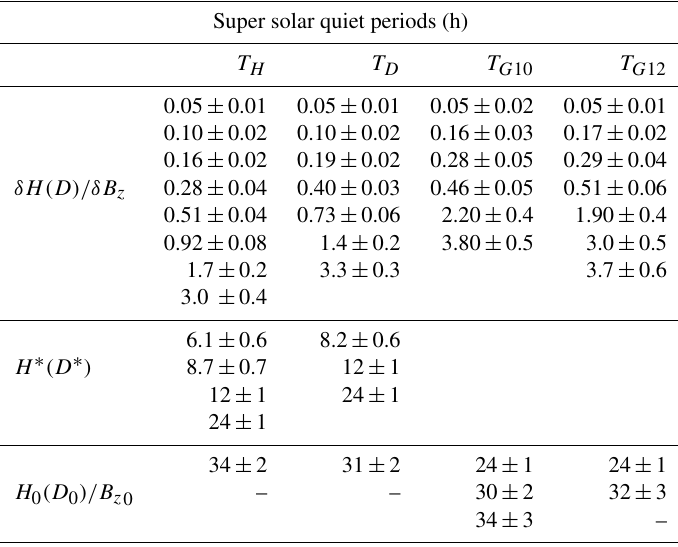
Figure 2. SSQ, 10–12 October 2003: empirical modes extracted via EMD from AQU H component (left panels) and AQU D component (right panels). The modes and the residue are expressed in nanotesla, and the time resolution is 1min. Table 1. Mean periods of intrinsic modes during the super solar quiet period (the dash corresponds to the period of the residue r(t) which cannot be evaluated). G10 and G12 refer to GOES10 and GOES12 satellites,